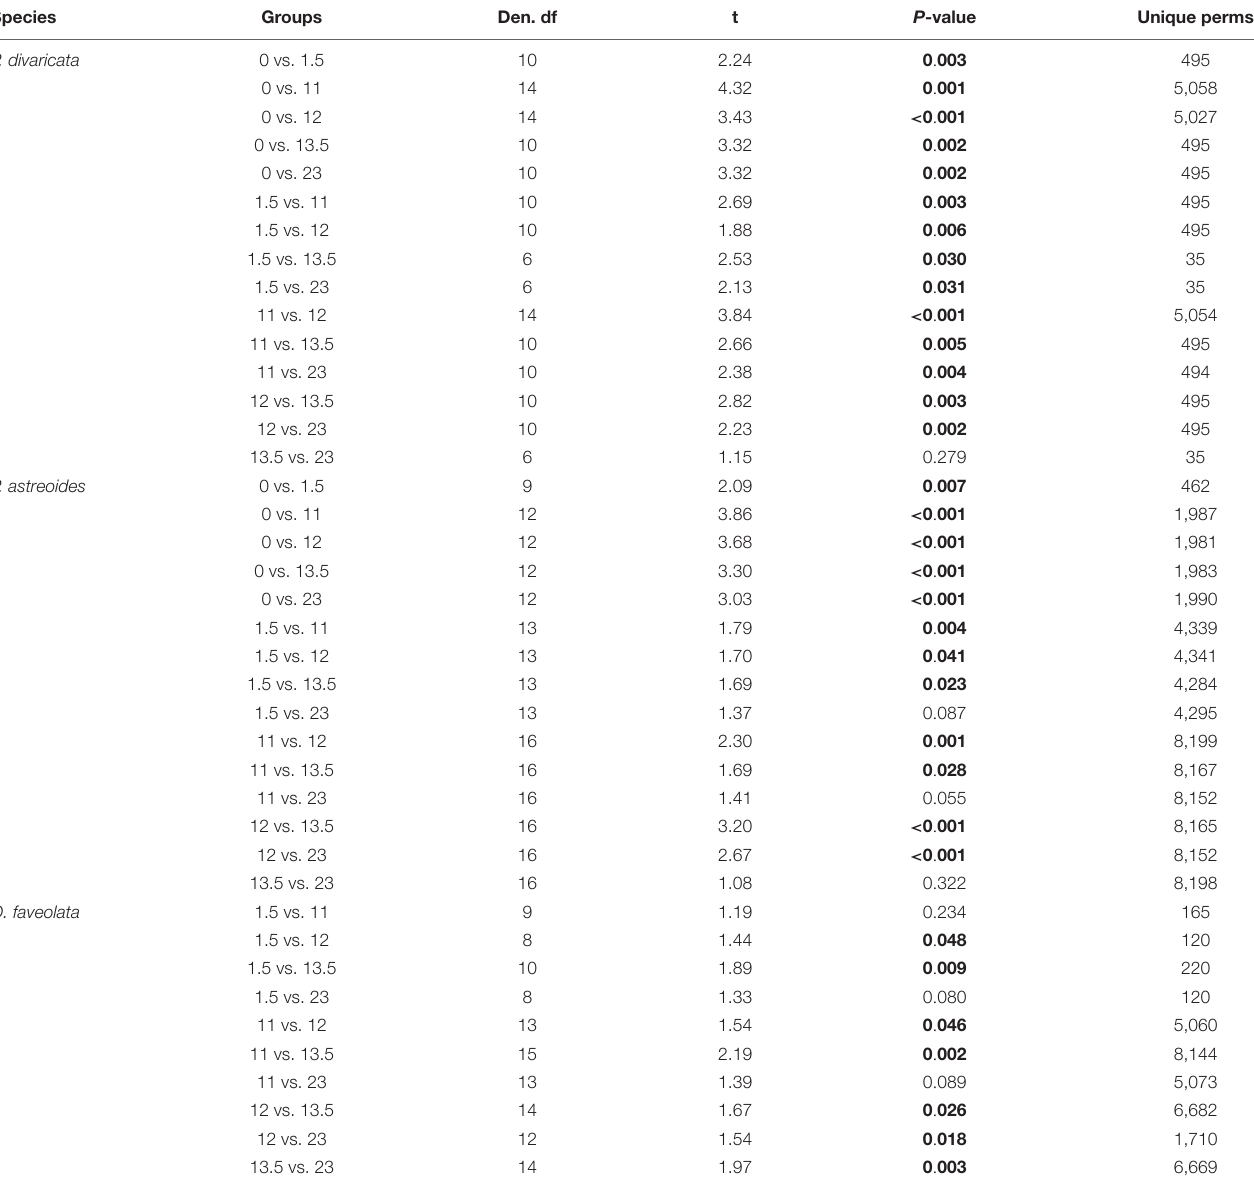
TABLE 2 | Results of the pair-wise tests from the one-way PERMANOVAs testing the effect of time on coral physiological profiles of Porites divaricata , Porites astreoides, and Orbicella faveolata. Species Groups Den. df t P -value Unique